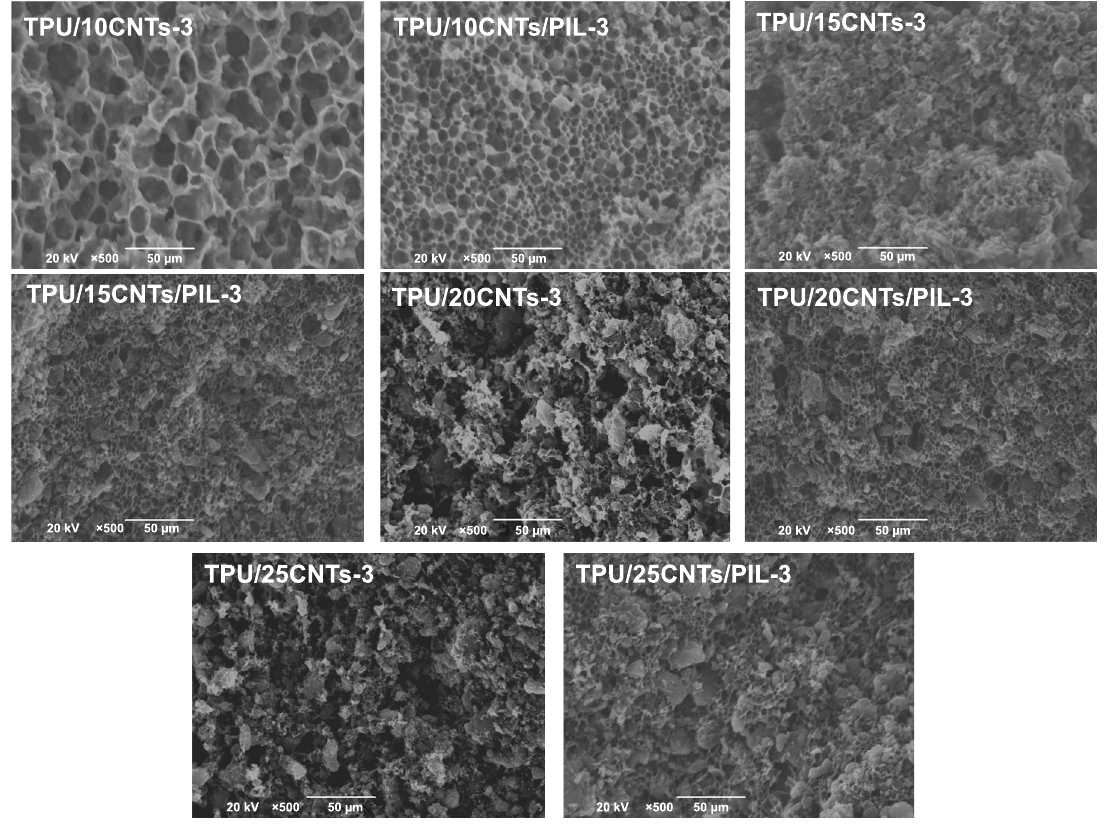
Fig. 2 Typical SEM images for fracture morphology of microcellular TPU/CNTs and TPU/CNTs/PIL composite foams with 3 min evaporate